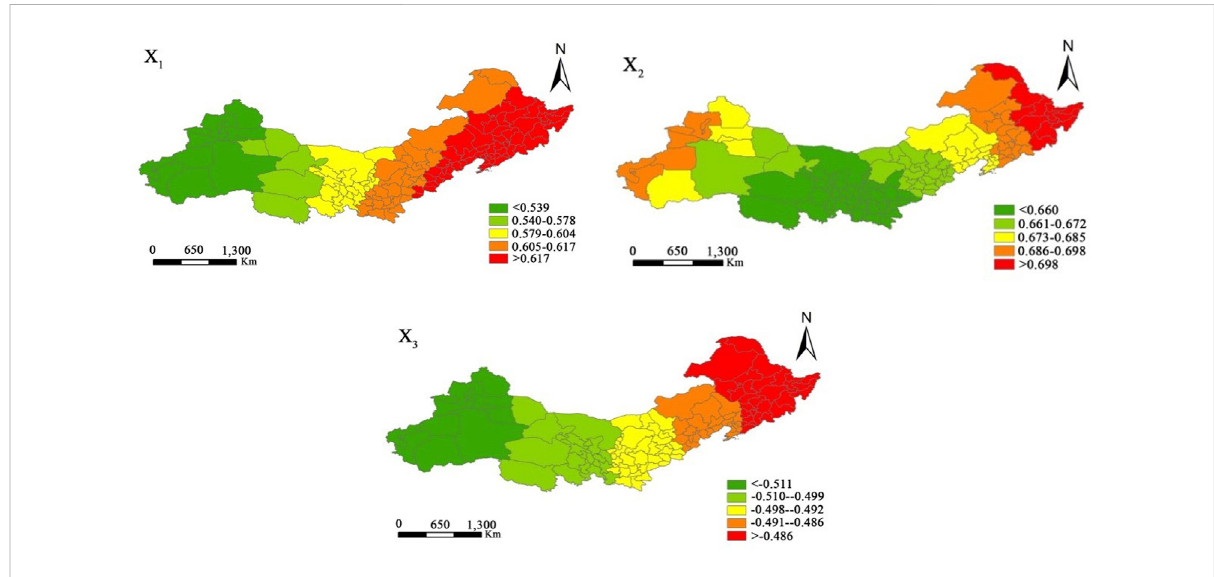
FIGURE 5 Spatial Distribution of Regression Coef fi cien ts of the GWR Model (2006).